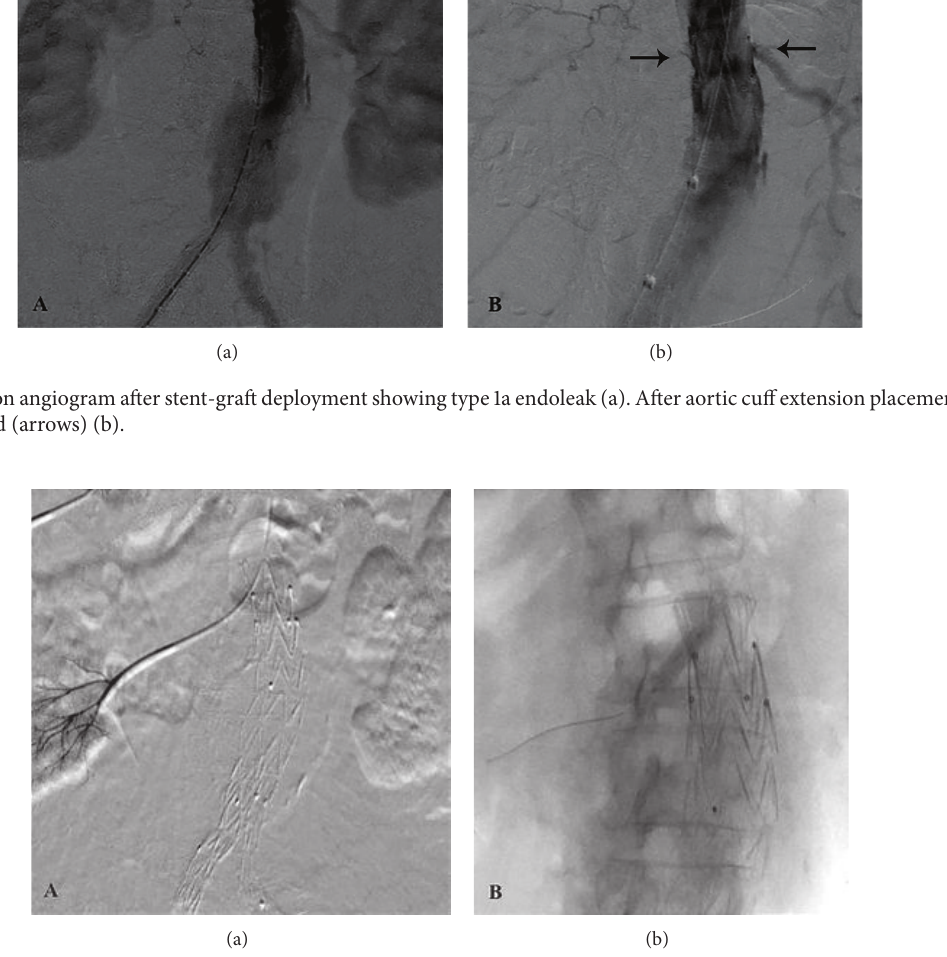
Figure 3: Successful recanalization (a) and stent placement (b) into right renal artery from left brachial approach.